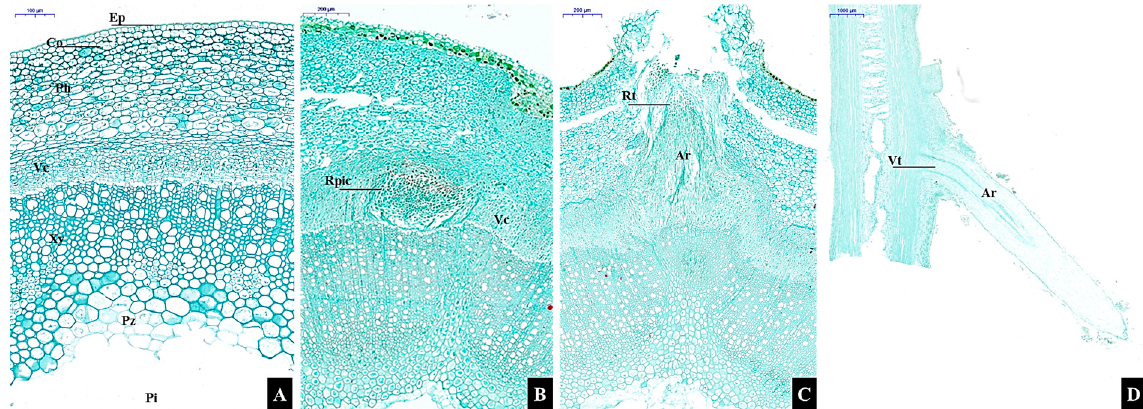
Figure 3. Anatomical changes in the rooting process of E. ulmoides twig cuttings. ( A – D ) The rooting situation of cutting seedlings on the 0th, 18th, 26th and 32nd day of E. ulmoides . Vc—Vascular cambium; Ph—Phloem; Xy—Xylem; Ve—Vessel; Ep—Epidermis; Co—Cortex; Pz—Perimedullary zone; Pi—Pith; Rpic—Root primordium initial cell; Ar—AR; Vt—Vascular tissue; Rt—Root tip.